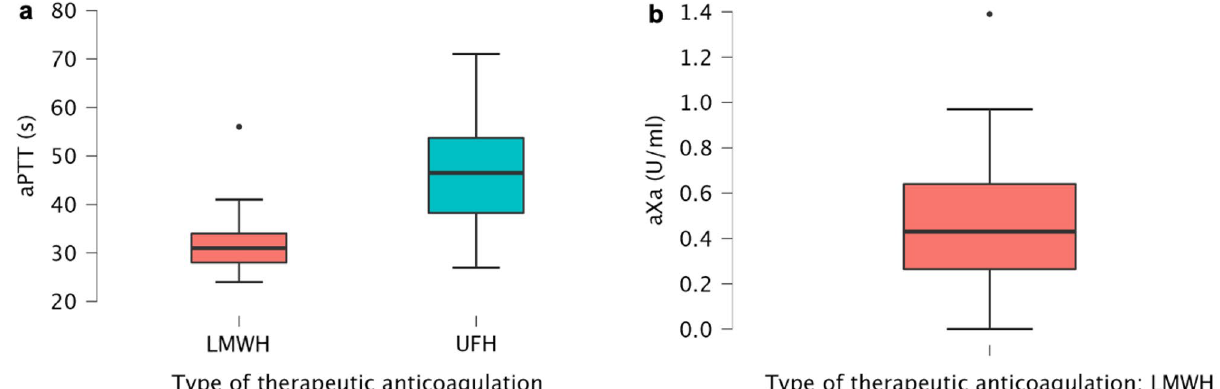
Figure 3. Box and whisker plots with min., max., 25th, 50th (median) and 75th percentiles and outliers. ( a ) aPTT (s) and ( b ) aXa (U/ml) levels of patients treated with therapeutic dose anticoagulation (UFH, LMWH = enoxaparin) at the time point of